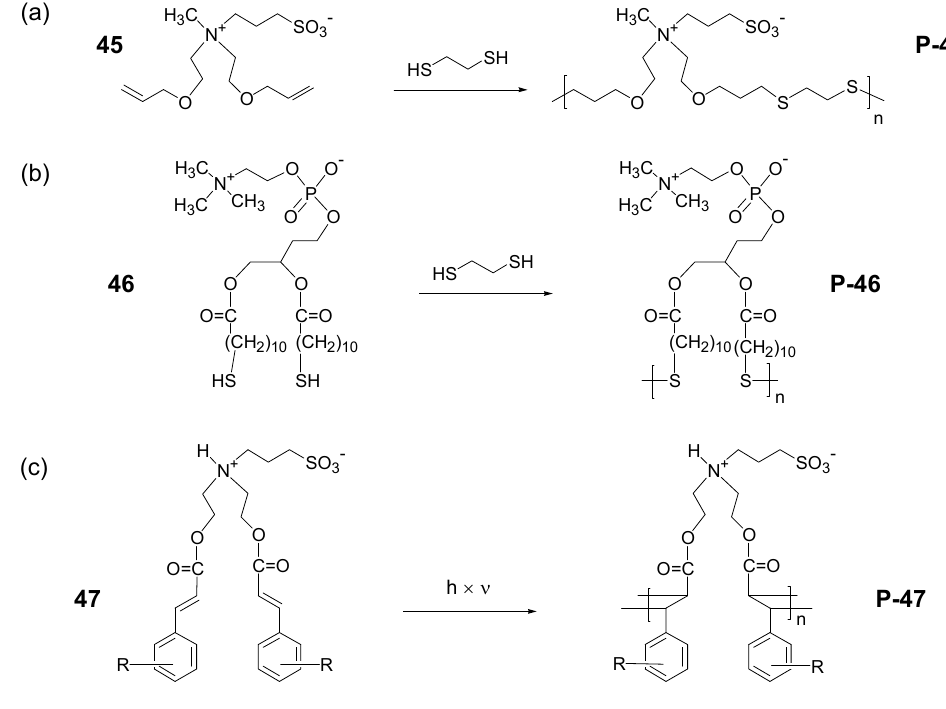
Figure 8. Examples for polyzwitterions produced via step growth polymerization: